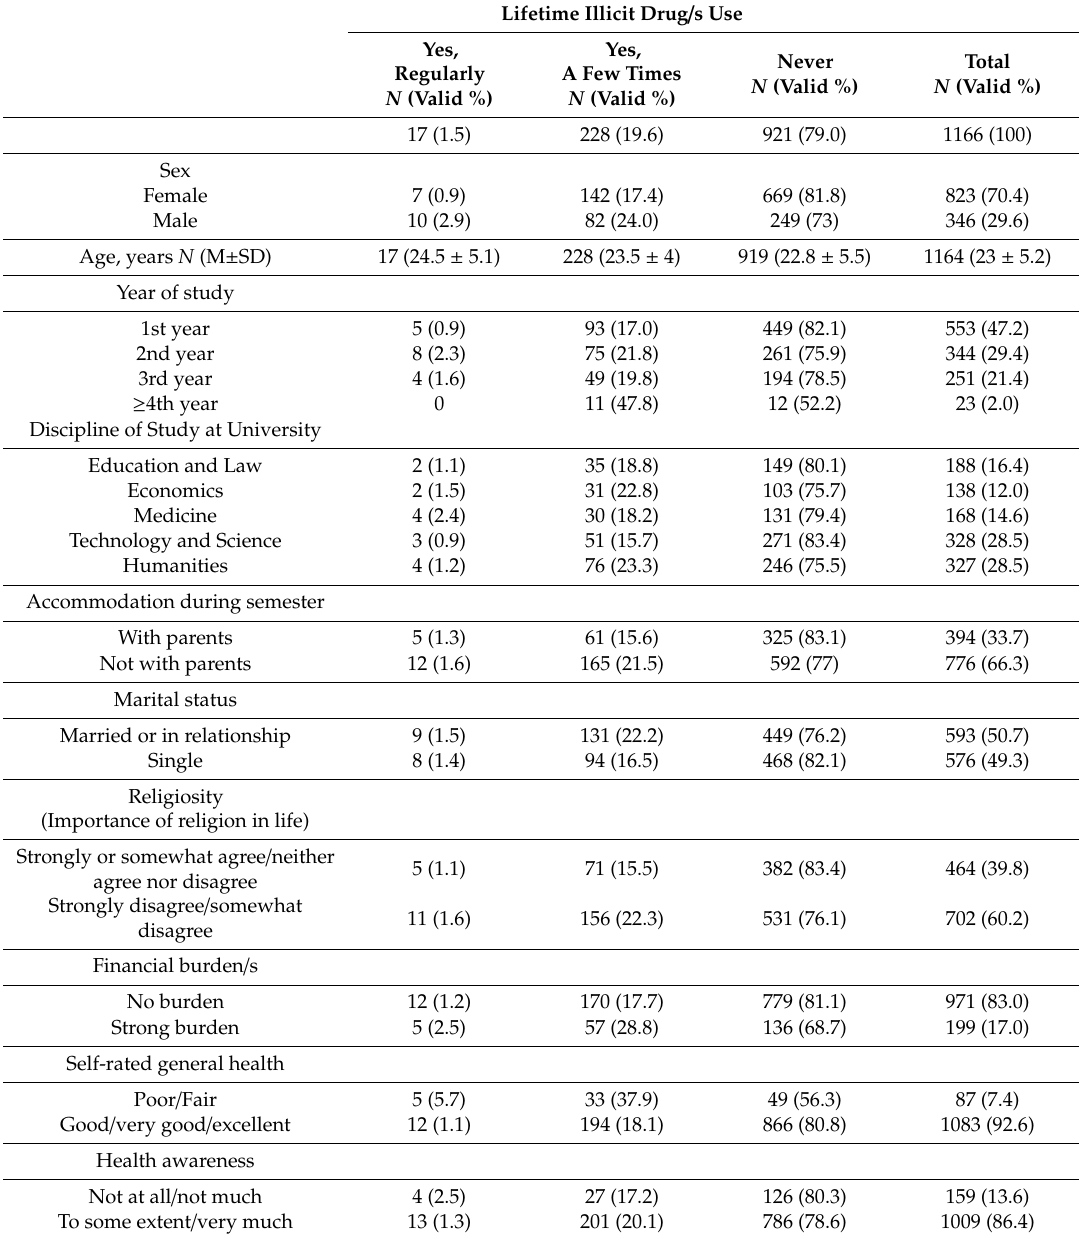
Table 1. Socio-demographics and lifetime illicit drug / s use of university students in Finland.